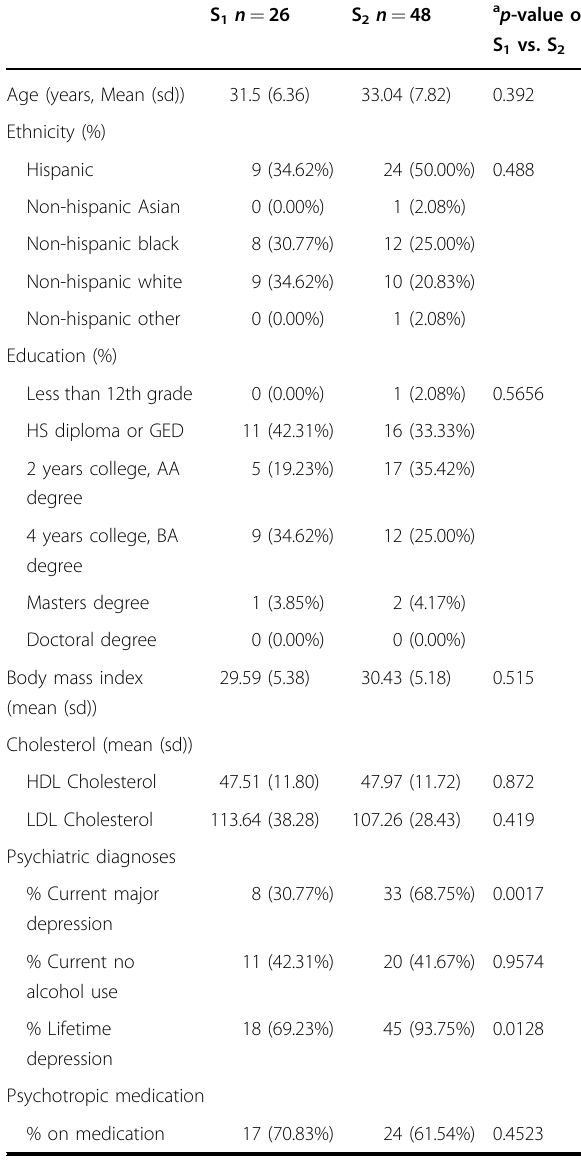
Table 3 Comparison of selected characteristics of S1 and